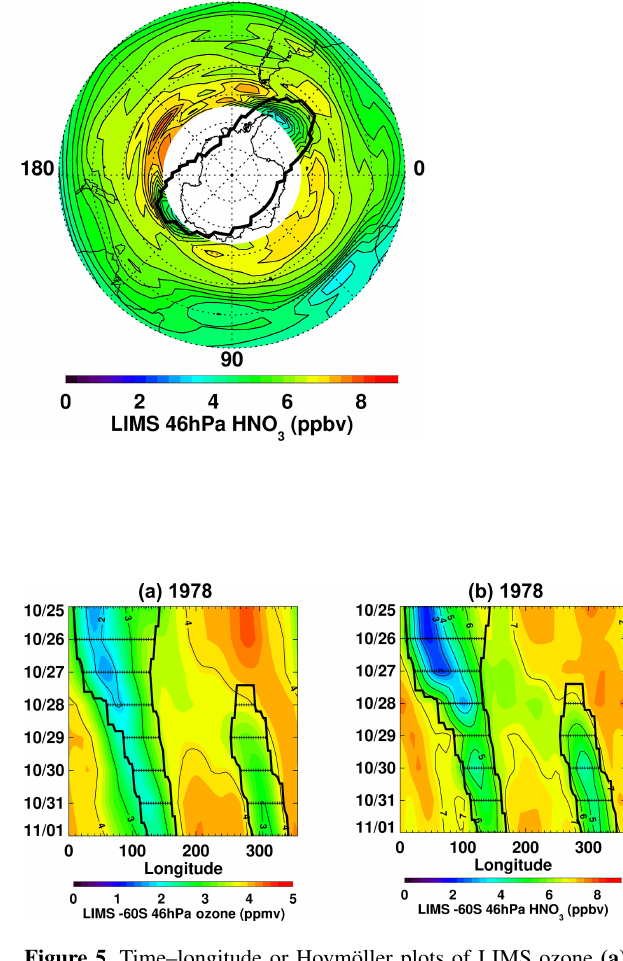
Figure 5. Time–longitude or Hovmöller plots of LIMS ozone (a) and HNO 3 (b) for 60 ◦ S and 46hPa. The ERA-40 vortex edge is shown as thick black contours, and the vortex interior has horizontal dotted lines.